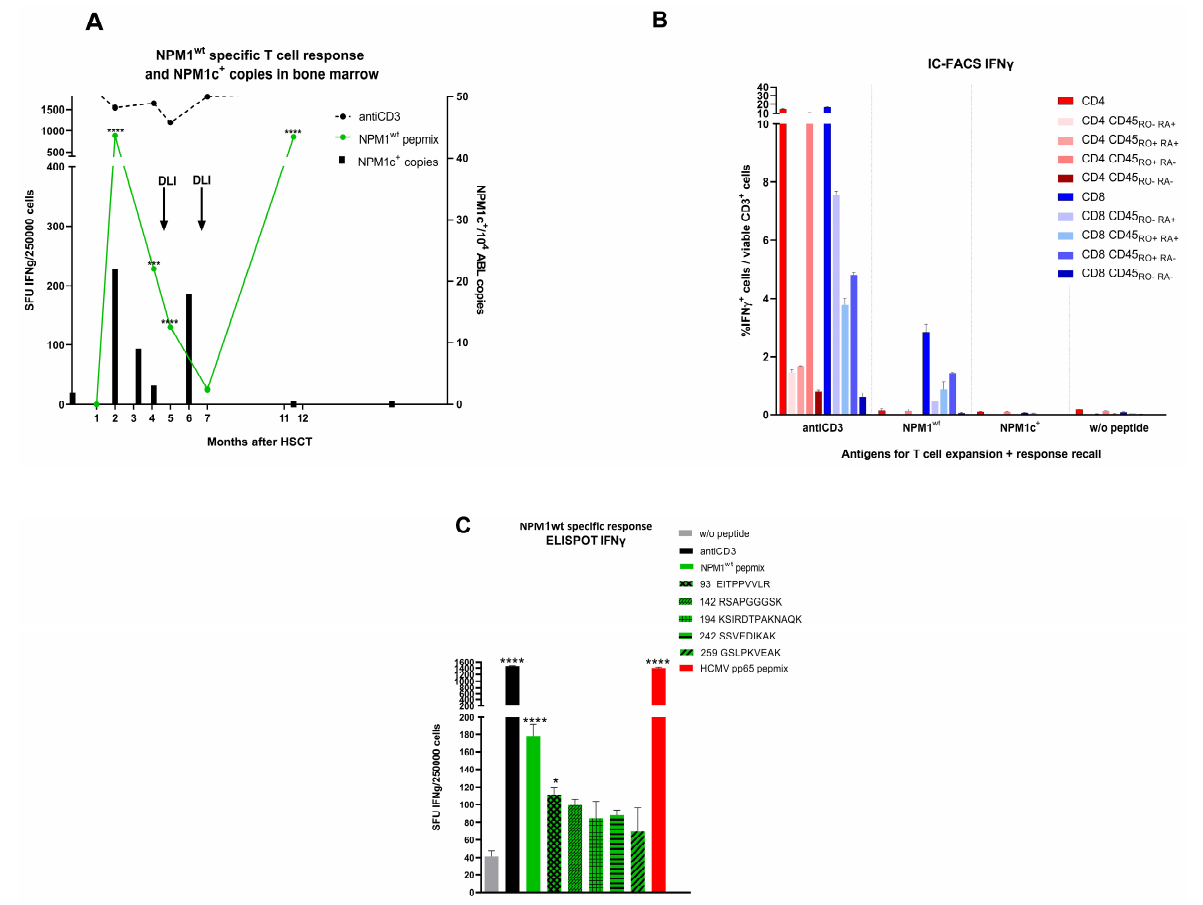
Figure 1. Nucleophosmin-specific T cell responses in an AML patient after HSCT. ( A ) Frequency of spot-forming units (SFU) specific for NPM1 wt detected by ELISPOT-IFN γ and result of quantification of NPM1c + transcripts in bone marrow. Time of DLI is denoted by arrows. ( B ) The phenotype of NPM1 wt -specific T cells at month +3 producing IFN γ determined by IC FACS. ( C ) Frequency